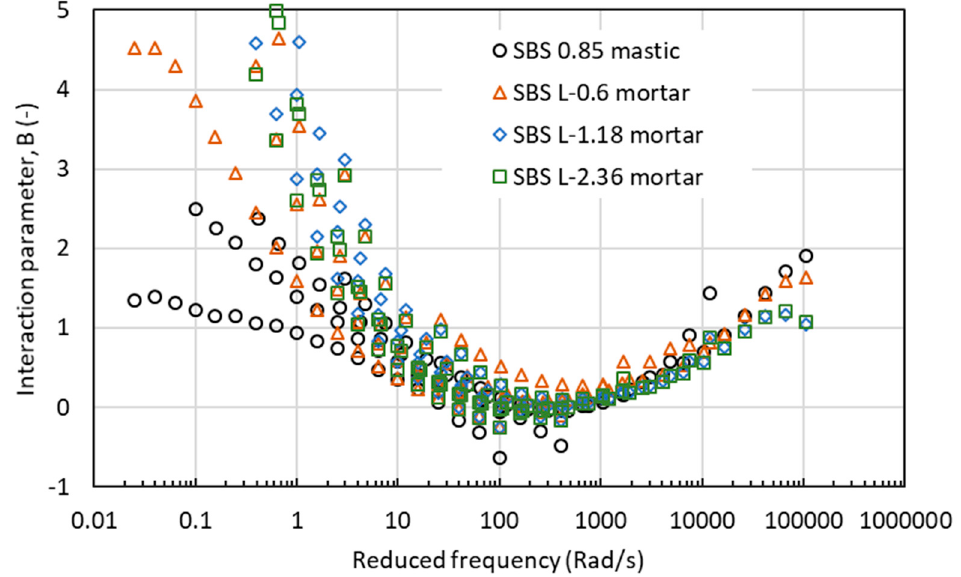
Figure 13. Interaction parameter of B values for asphalt mastic and mortar based on AC ‐ 20 mixture.